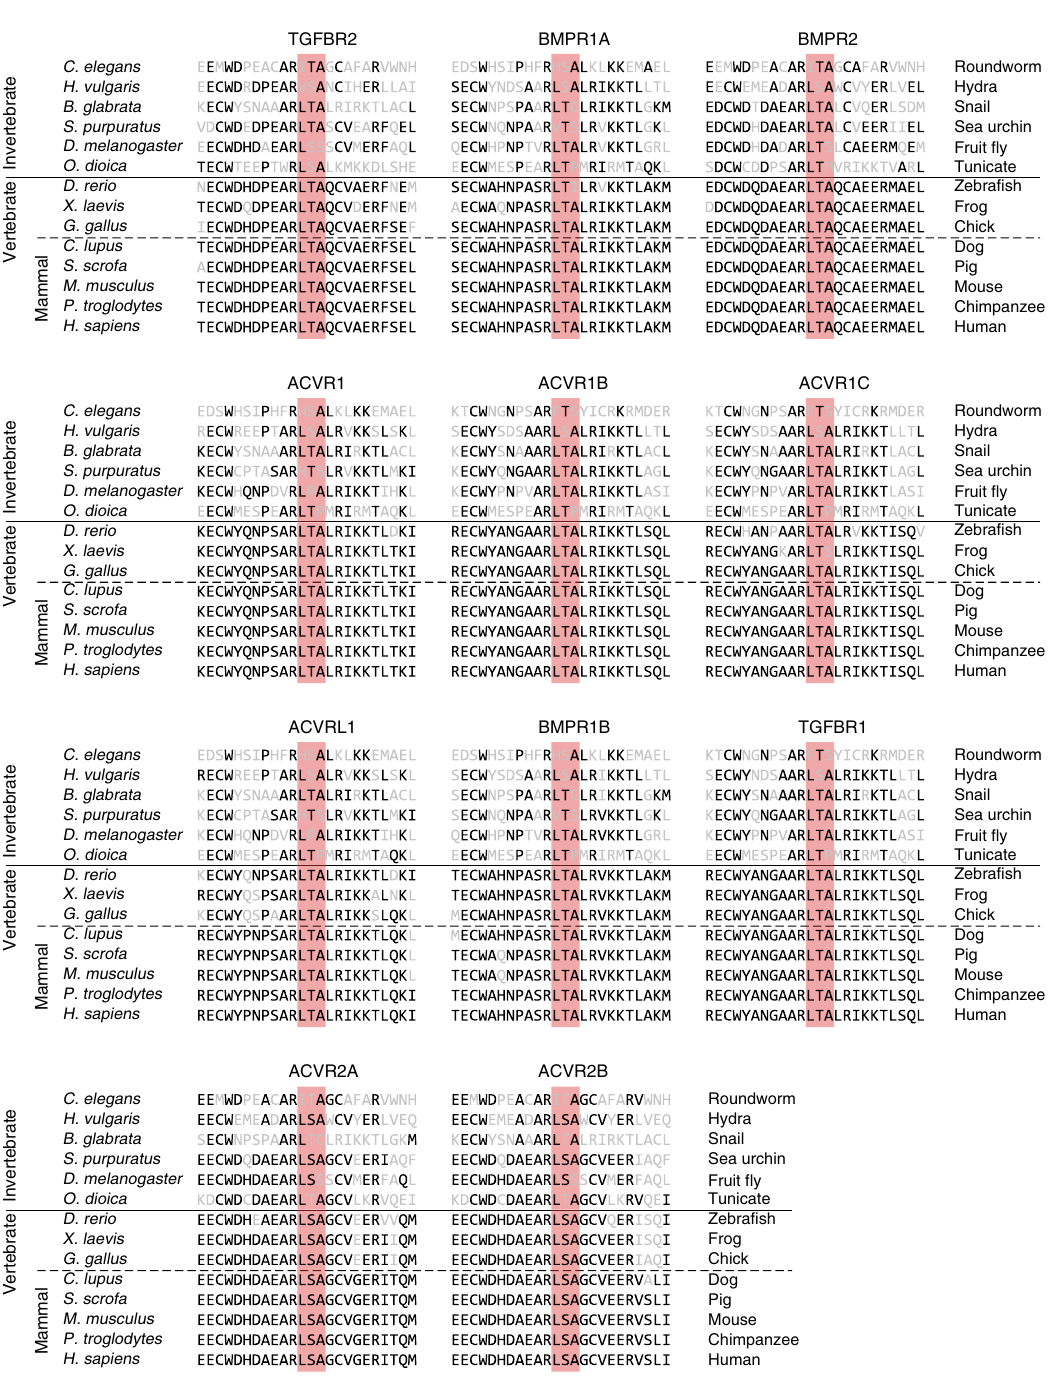
Fig. 3 LTA motif in TGF- β superfamily receptors. Protein sequence alignment of TGF- β superfamily receptors shows conservation of LTA motif in nine receptors and a LSA motif with a conservative substitution of serine for threonine in two